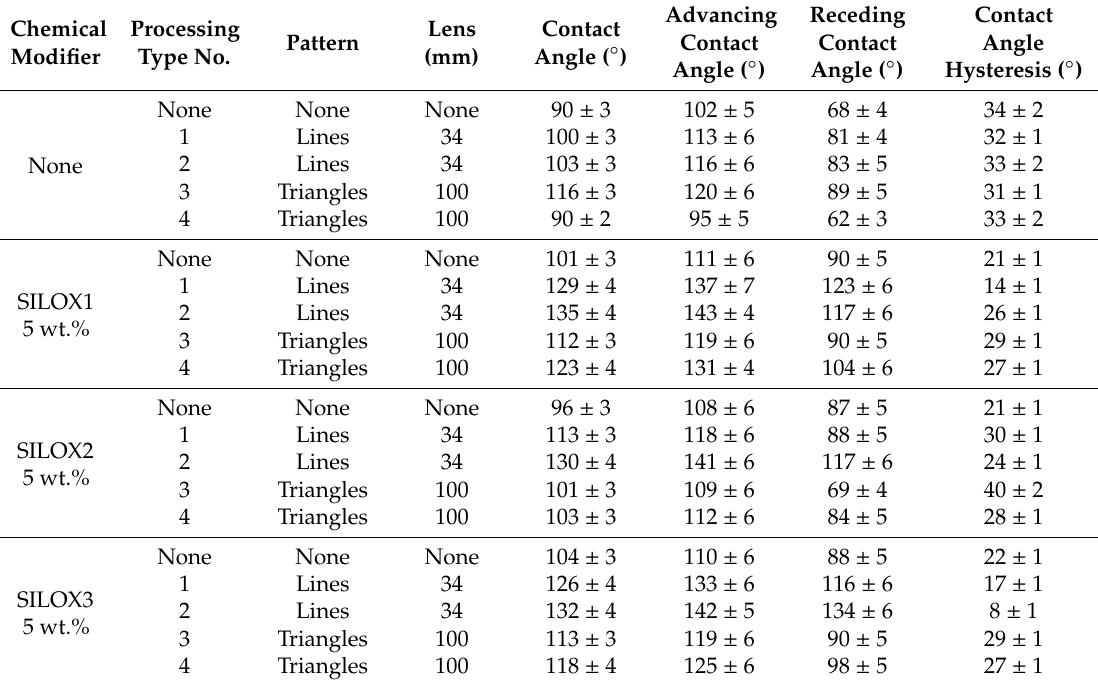
Table 4. Wettability characteristics of the